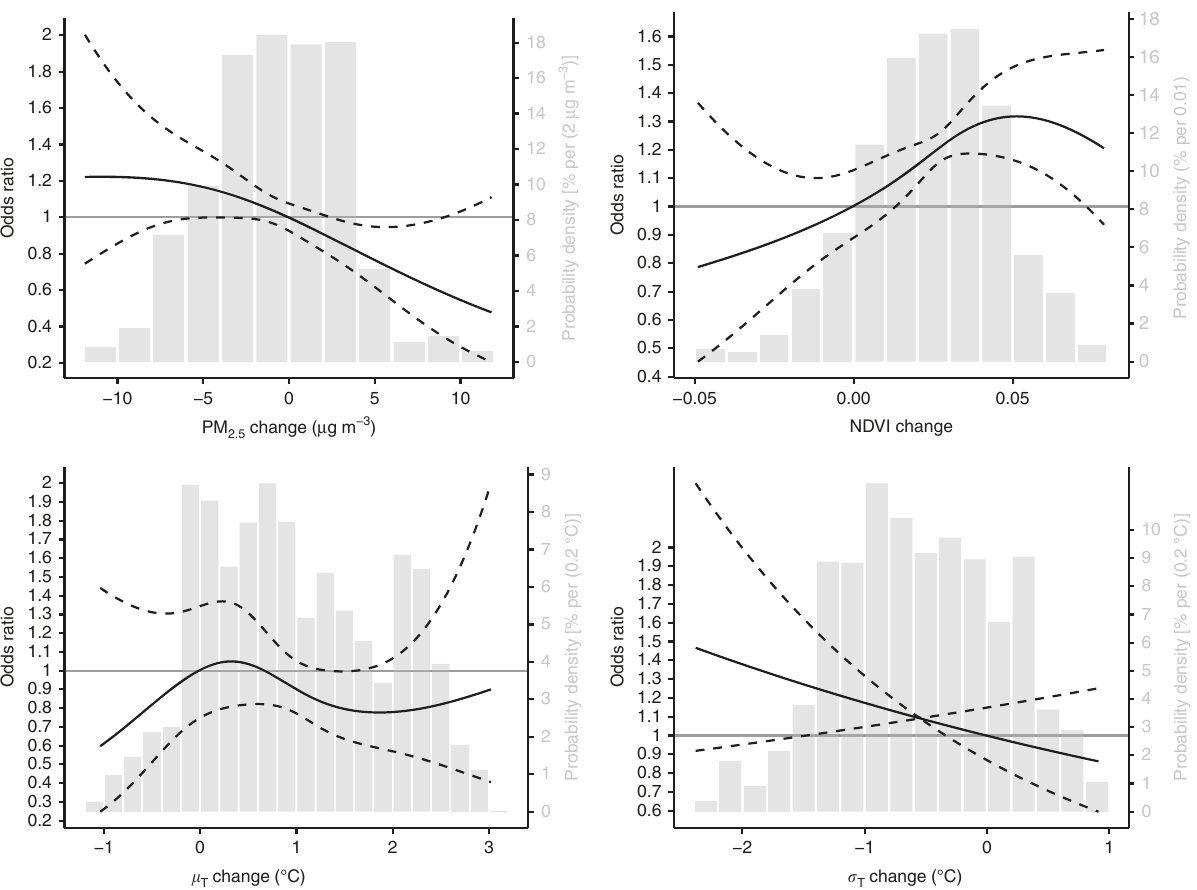
Fig. 1 Exposure – response curves. The curves (the solid lines) with 95% con fi dence intervals (dashed lines) are estimated by the fully adjusted nonlinear effect models. The covariates include changes in alcohol consumption, education, migration, obesity, physical activity, and smoking status, as well as baseline age, alcohol consumption, education, diet type, gender, income, marital status, nationality, physical activity status, obesity status, area of residence, and smoking status in 2013. The histograms (gray bars) present the distributions of the environmental changes among the studied adults. For the exposure – response curves, please refer to the left y -axis; for the distributions, please refer to right y